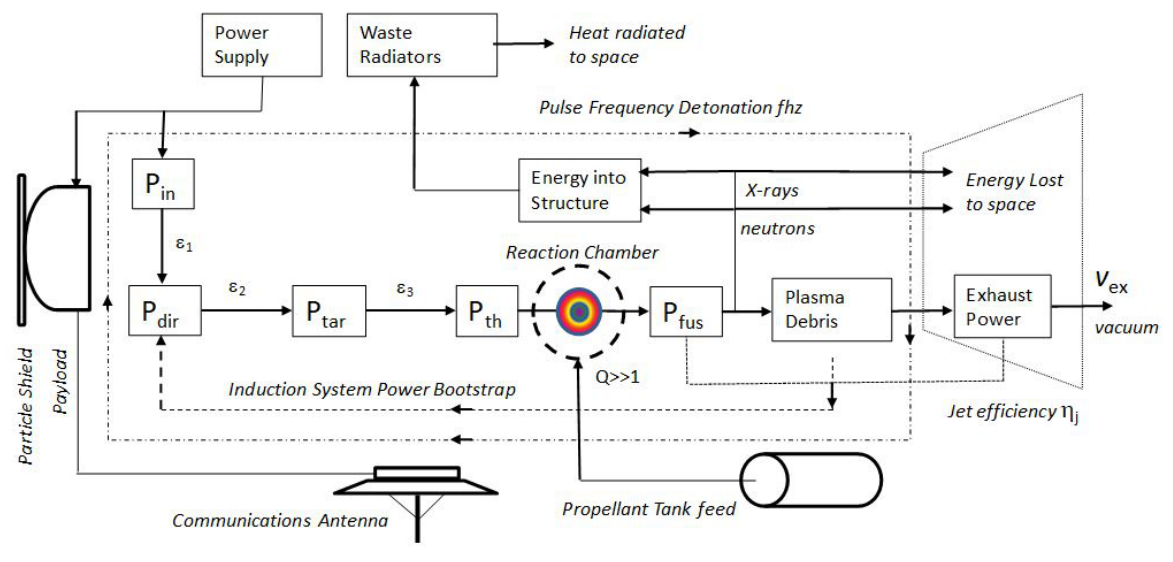
Figure 5. Illustration of an ICF spacecraft and its engine power